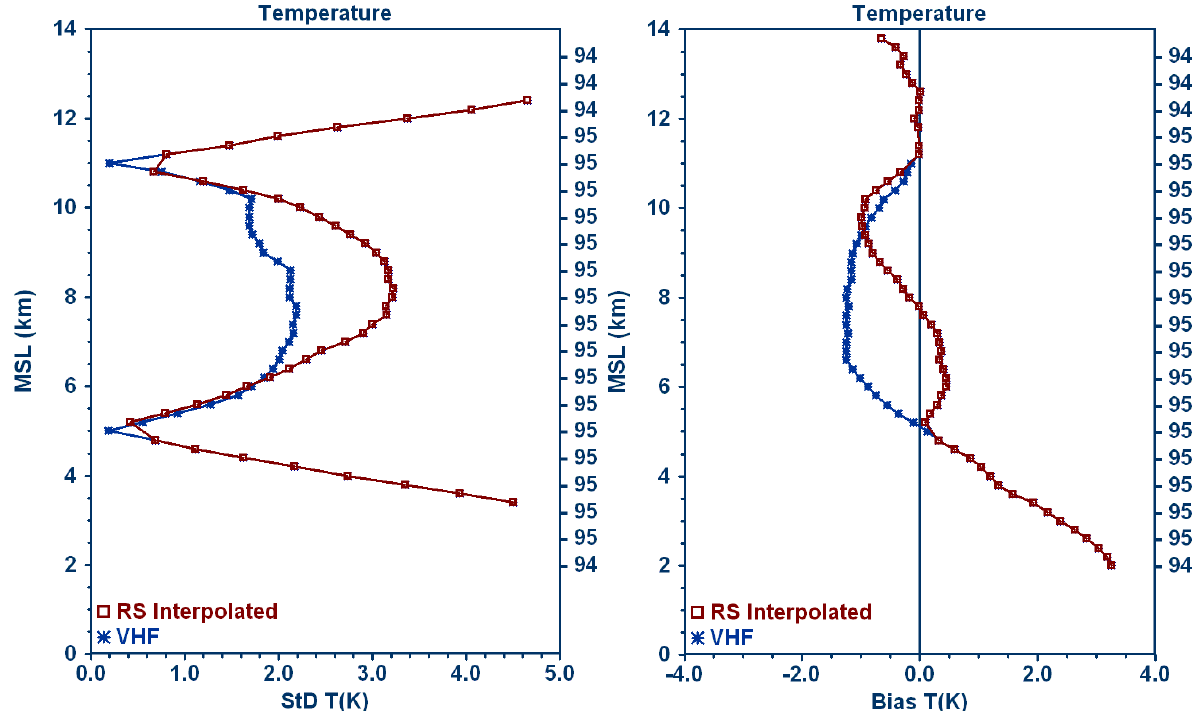
Fig. 7. Same as Fig. 6 with reference values between 5 and